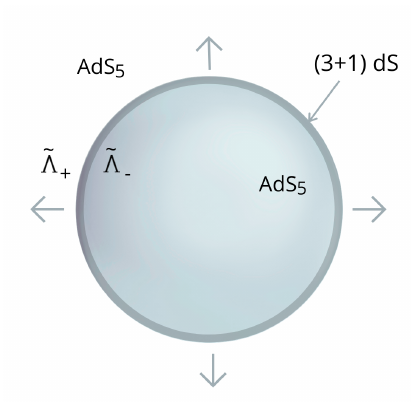
Figure 1. An AdS 5 vacuum decaying to another AdS 5 vacuum with more negative vacuum energy via bubble-nucleation of a true